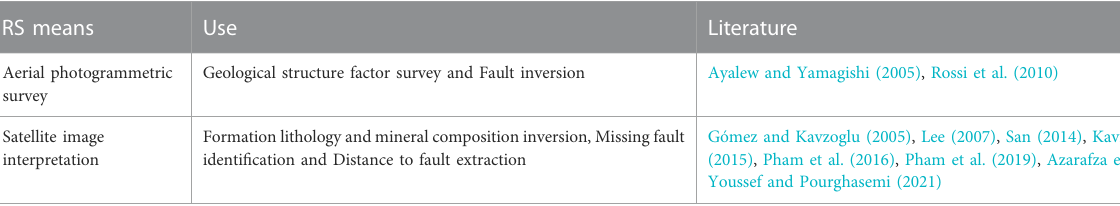
TABLE 3 Remote sensing means for obtaining geological